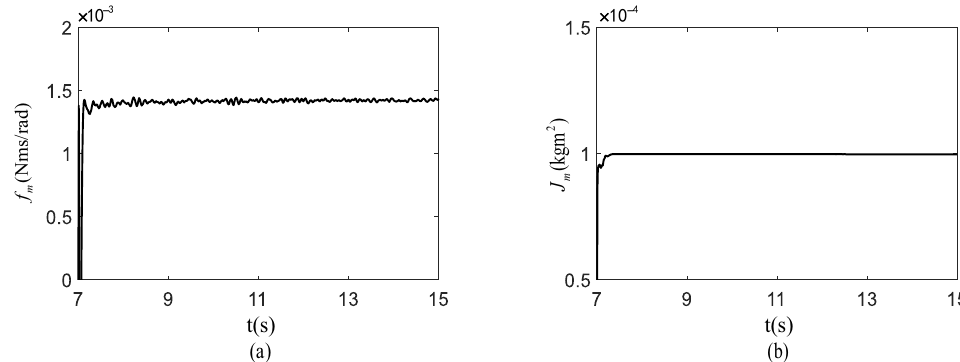
Figure 6. Estimation results: ( a ) Estimate of f m . ( b ) Estimate of J m .